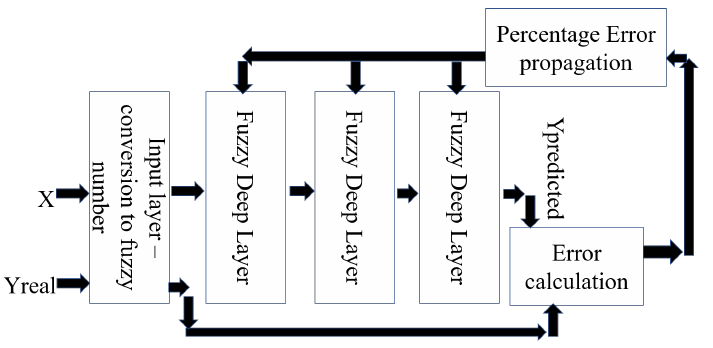
Figure 8. Third learning algorithm.